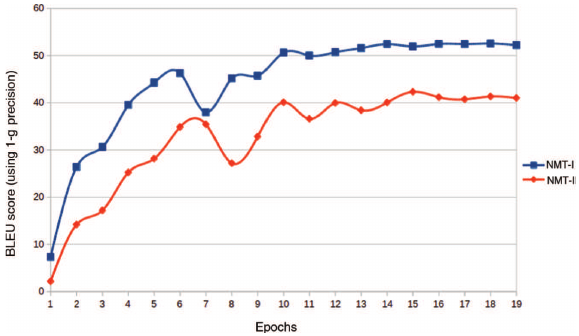
Figure 7: BLEU Score Achieved by NMT-I and NMT-II at Different